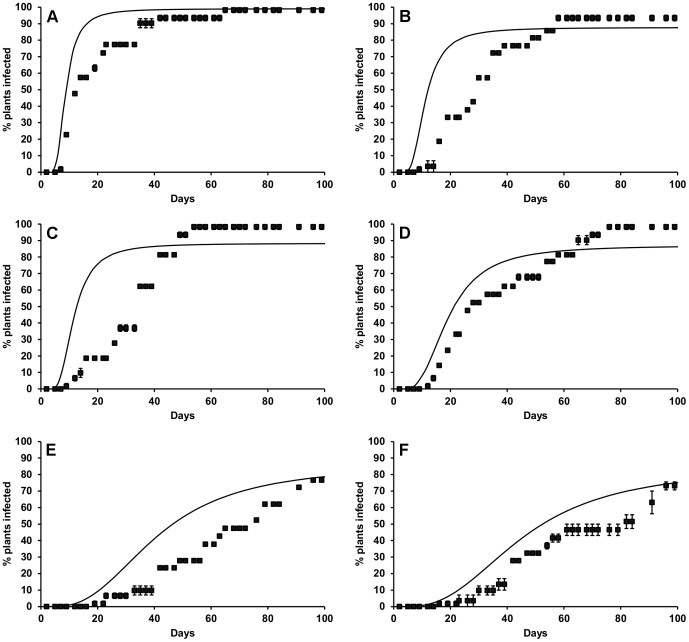
Observed and modelled S. sclerotiorum disease development in lettuce at A) 100% RH (RMSE = 51.8), 20°C and 80% RH at B) 25°C (RMSE = 59.4), C) 20°C (RMSE = 54.3), D) 15°C (RMSE = 15.0), E) 10°C (RMSE = 81.8)and F) 7°C (RMSE = 57.5).Points represent observed data, lines represent model. Error bars are the standard error of the mean (three replicates).